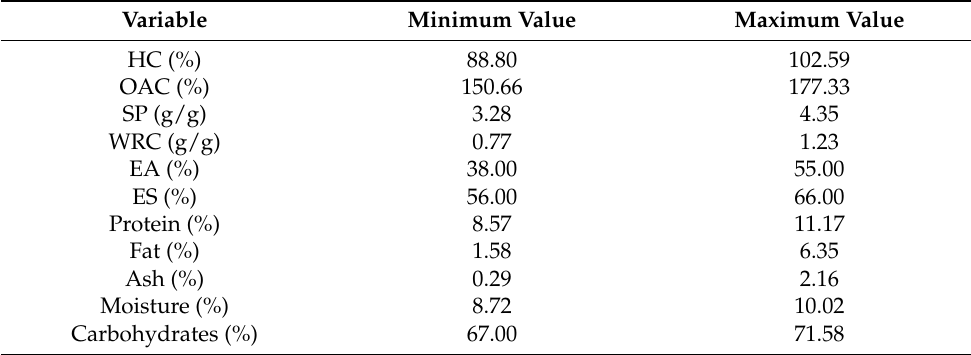
Table 2. Minimum and maximum values of the responses used in the experimental design. Variable Minimum Value Maximum